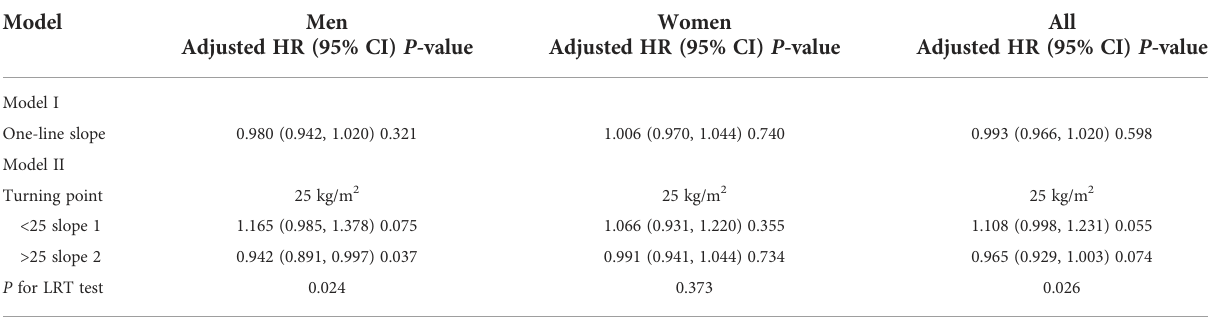
TABLE 3 One-line linear regression or segmented line regression results for the relationship between glioma risk and BMI.